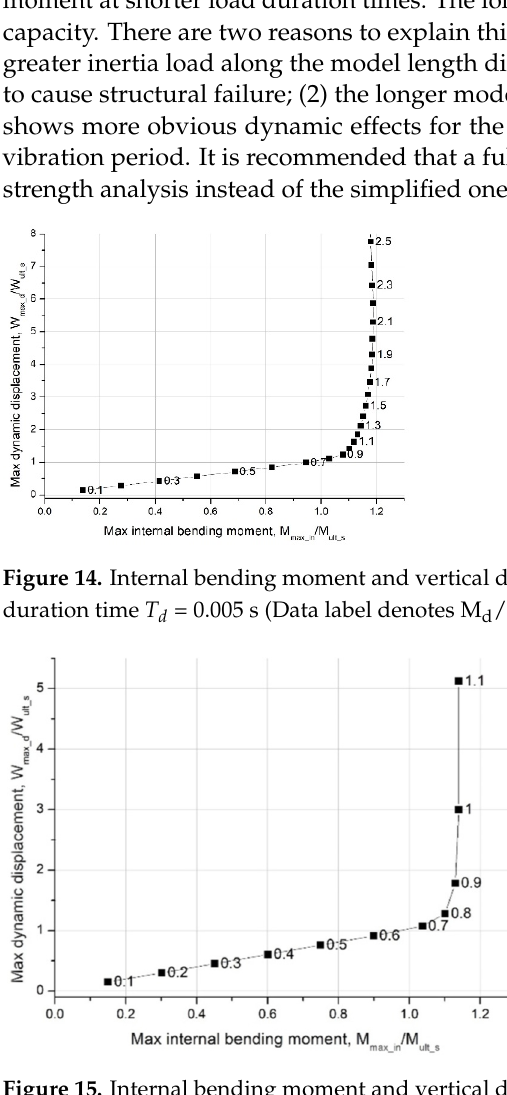
Figure 15. Internal bending moment and vertical displacement for mid-span box girder M1 at load Table 4. Comparison of dynamic ultimate moment for box girder with various length.